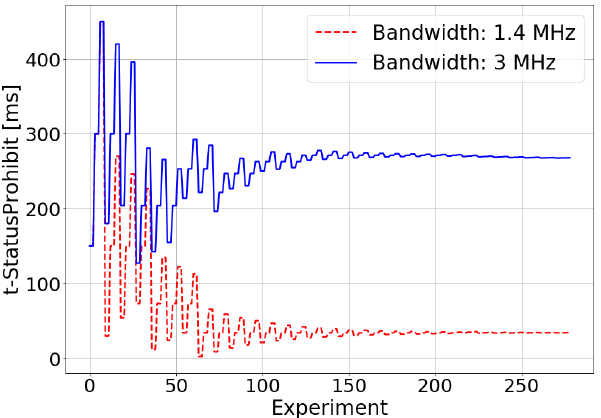
Figure 6. Simulated scenario—t-StatusProhibit adjustment.